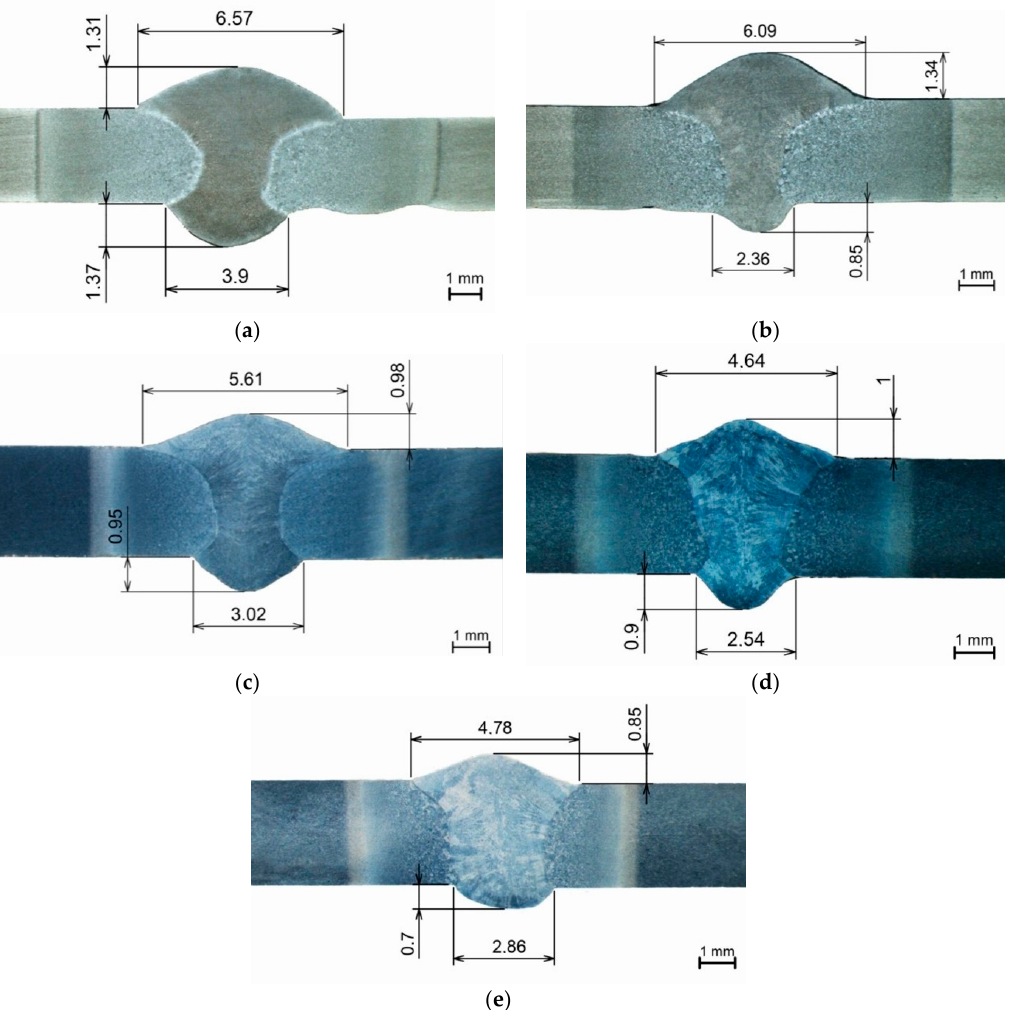
Figure 9. Macrostructure of the assessed welded joints: ( a ) GMAW-S, ( b ) GMAW-P, ( c ) GMAW-CMT, ( d ) MCAW-S, and ( e ) MCAW-S cooled.